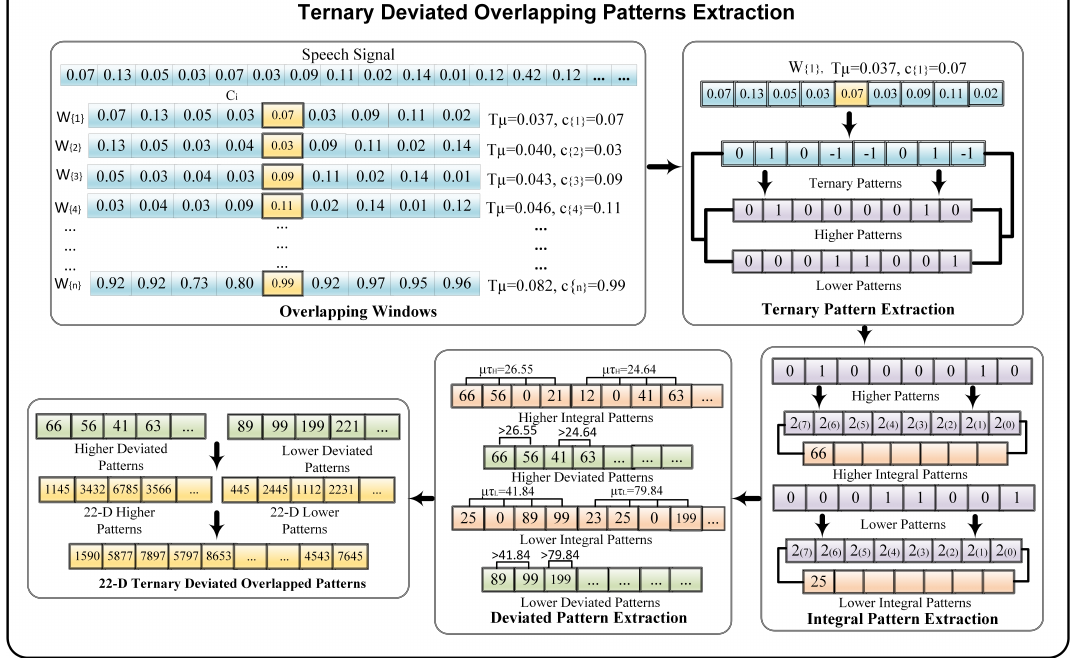
Figure 5. Extraction of the proposed Ternary Deviated Overlapped Patterns